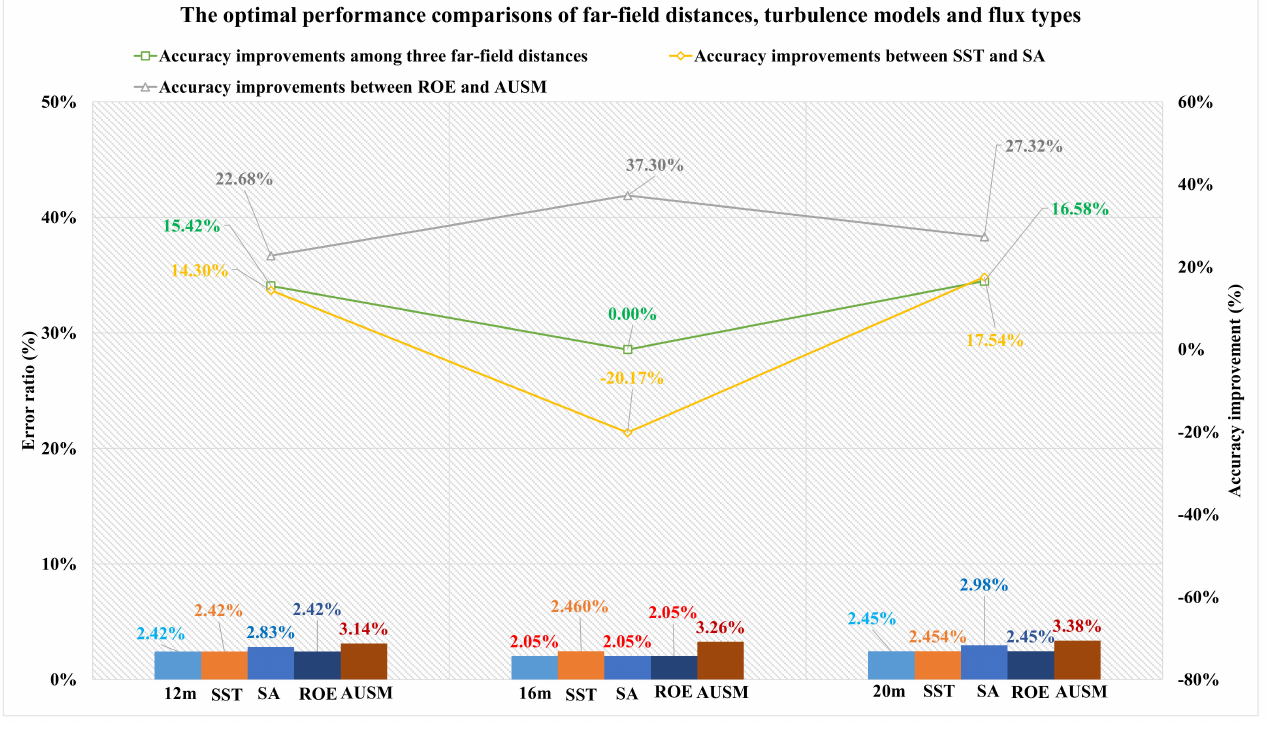
Figure 38. The optimal performance comparisons of the far-field distances, turbulence models, and flux types. Table 25. The mean error ratios and the maximum accuracy decline under different